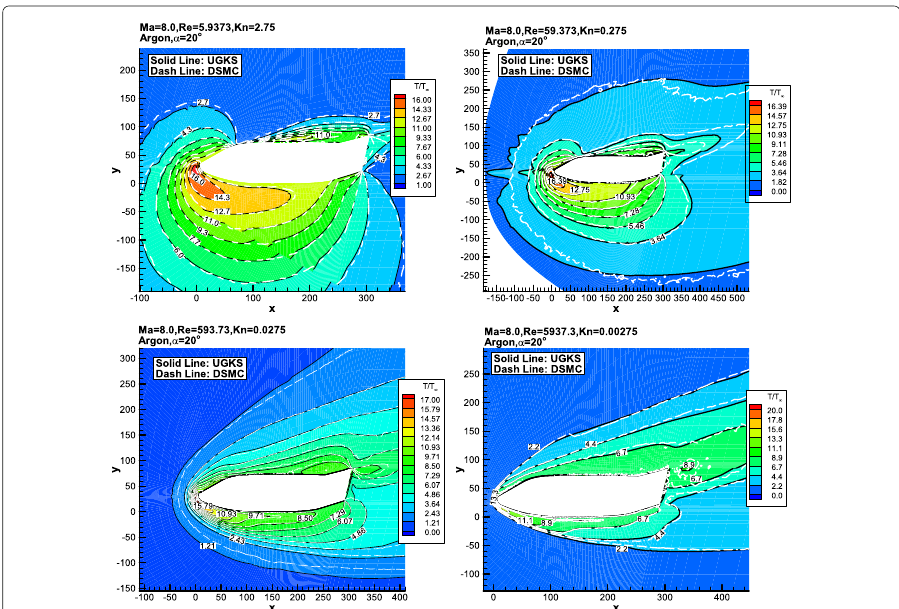
Fig. 4 Comparison of temperature flow fields. Solid black line: UGKS; Dash white line: DSMC be observed, especially for heat flux and friction. However, even with the presence of the statistical scatter, the DSMC results agree well with the UGKS results not only in terms of trend, but also in terms of magnitude. The leeward side is nearly vacuum. The pressure, heat flux and friction on most parts of this side are almost zero except a small region near the model head. The surface quantities on that region remain nearly constant because the